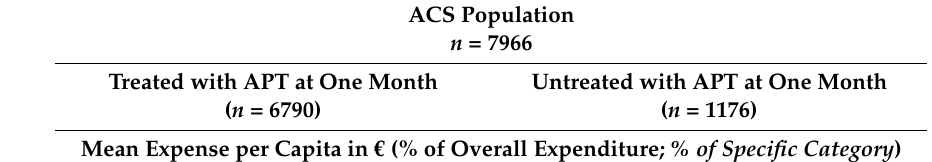
Table 4. Average per capita amounts paid by the Italian National Health Service during one-year follow-up for patients discharged in 2017 with a diagnosis of acute coronary syndrome.